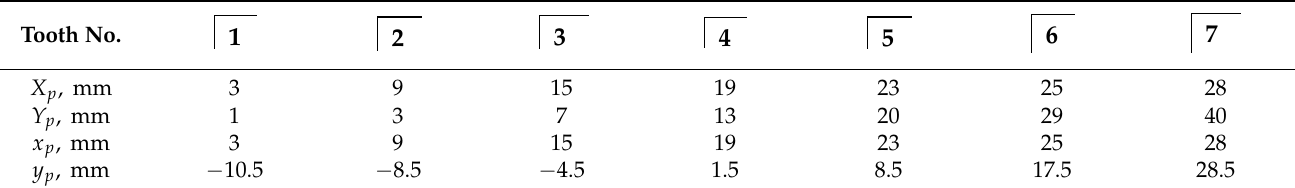
Table 2. Coordinates of the pole (tooth) in the original and central coordinate system. Tooth No.